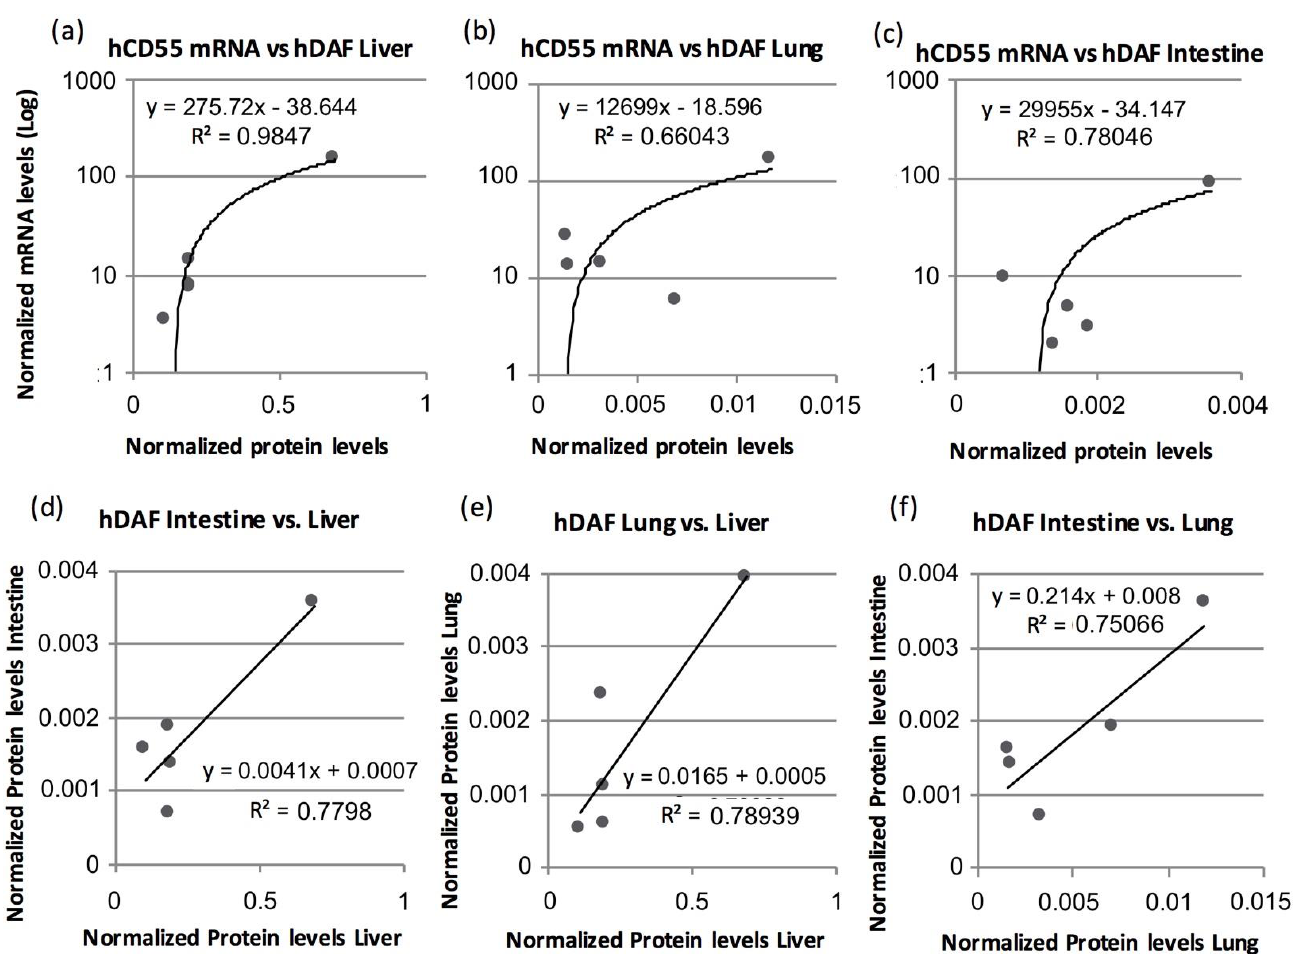
Figure 3. Transgene mRNA and protein levels can be correlated between tissues. Linear-regression plots showing paired data and trends of significant correlations calculated between hCD55 mRNA and hDAF protein expression in ( a ) liver, ( b ) lung and ( c ) intestine; and linear regression plots showing paired data and trends of correlations of hDAF levels between ( d ) liver and intestine, ( e ) liver and lung, and ( f ) lung and intestine. Only data combinations that obtained significant coefficient in the nonparametric Spearman rank correlation test were object of linear-regression calculation. Data from three female pigs and two male pigs are shown.